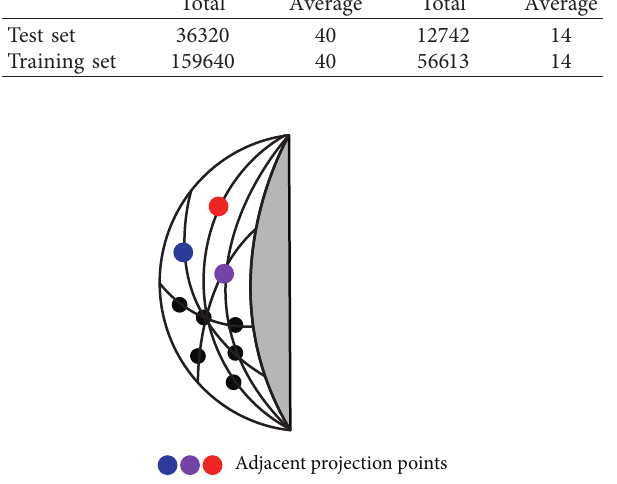
Figure 12: Adjacent projection